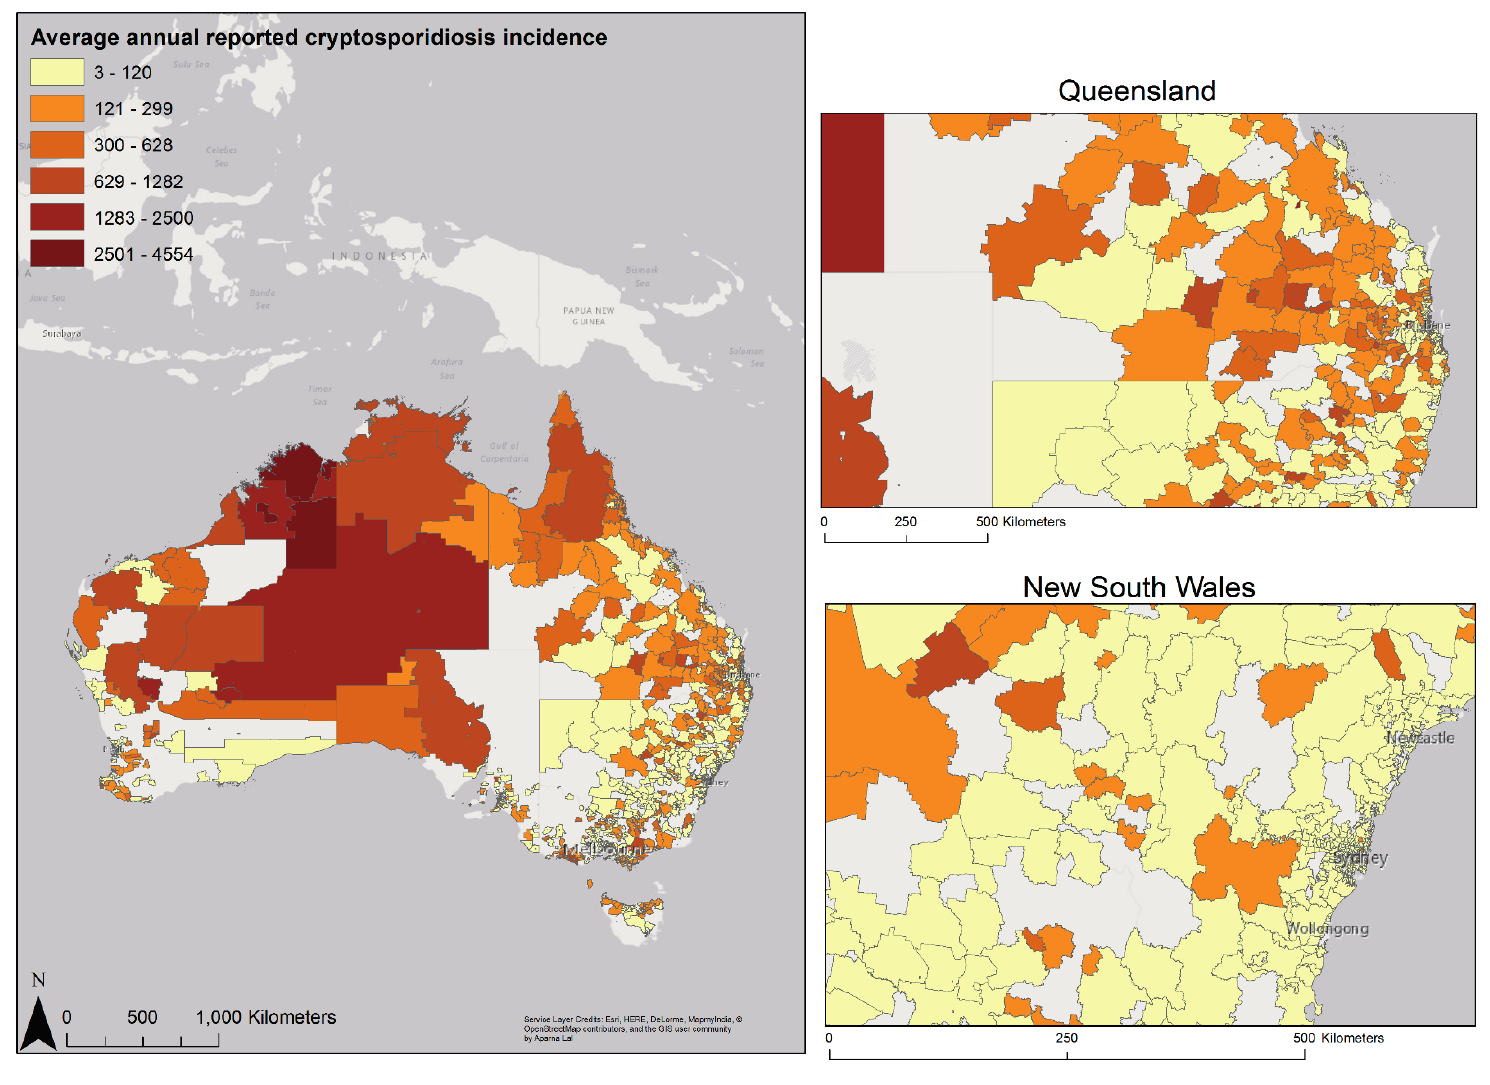
Figure 3. Average annual incidence of reported cryptosporidiosis in children <5 years by 2011 Postal area